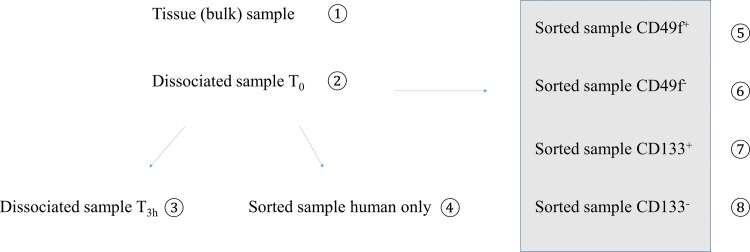
Schematic of experimental setup.Tumor tissue was extracted and gene expression profiles from 8 different samples per tumor were generated from 4 mice (i.e. total of 8x4 = 32 RNASeq profiles) of the same breast cancer PDX model, BRC13. The left part addressed the sample handling aspects of the procedure while the samples marked by the grey box were generated to investigate ITH present in this model. See text for details.